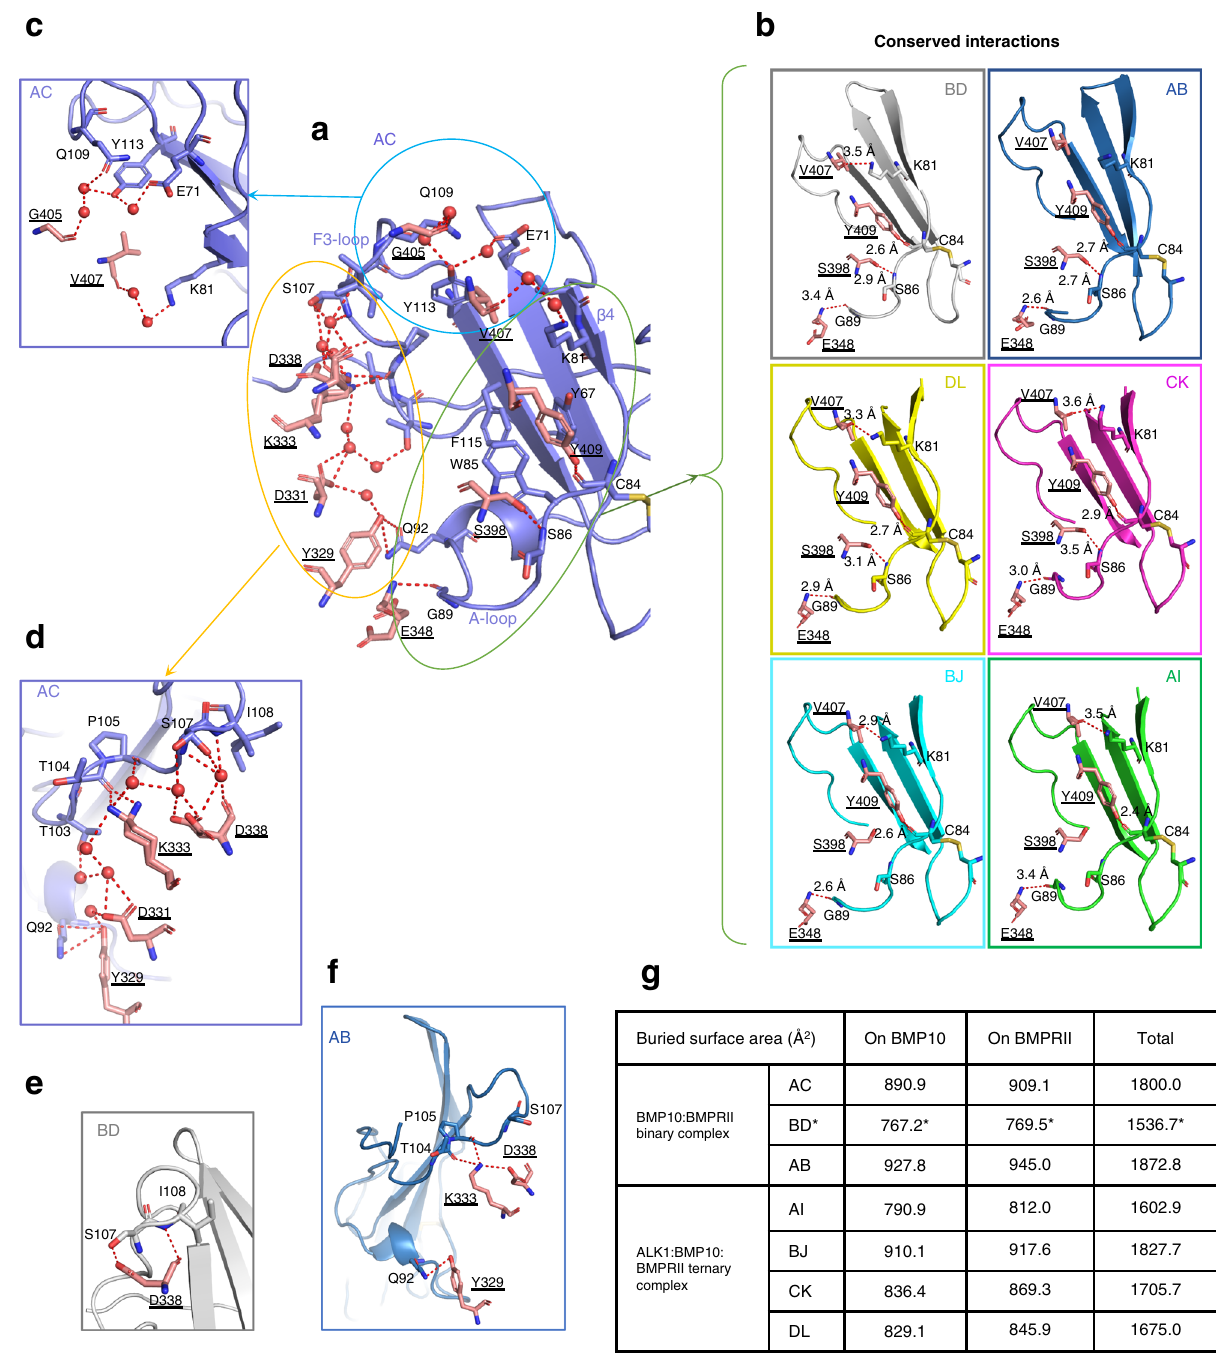
Fig. 4 Detailed BMP10:BMPRII interface interactions. a BMP10:BMPRII binding interface in complex AC. BMP10 (in coral)-binding surface on BMPRII (purple) can be broadly divided into three regions. The central hydrophobic triad (Y67, W85 and F115), the β 4 strand to the A-loop (green oval), the F3- loop and the region connecting the A-loop and the F3-loop (light blue circle and orange oval). b – f Detailed interactions between BMP10 and BMPRII, at the β 4 strand and A-loop region in all complexes ( b ), at the F3-loop ( c ) and the regions connecting the A-loop and the F3-loop in complex AC ( d ), at BMPRII S107 region in complex BD ( e ) and AB ( f ). BMP10 is shown in coral sticks throughout b – f , whereas BMPRII is in grey for complex BD, in dark blue for complex AB, in yellow for complex DL, in magenta for complex CK, in cyan for complex BJ and in green for complex AI. In a – f red dashed lines denote H- bonds, with distance all between 2.7-3.7 Å if not labelled. Underlined residue numbers are those from BMP10, and residues numbers in normal text are those from BMPRII. g Buried interface area between BMP10 and BMPRII in binary and ternary receptor complexes. *Complex BD has much smaller buried surface area because some sidechains at the interface were deleted between the A-loop and F3-loop due to poor